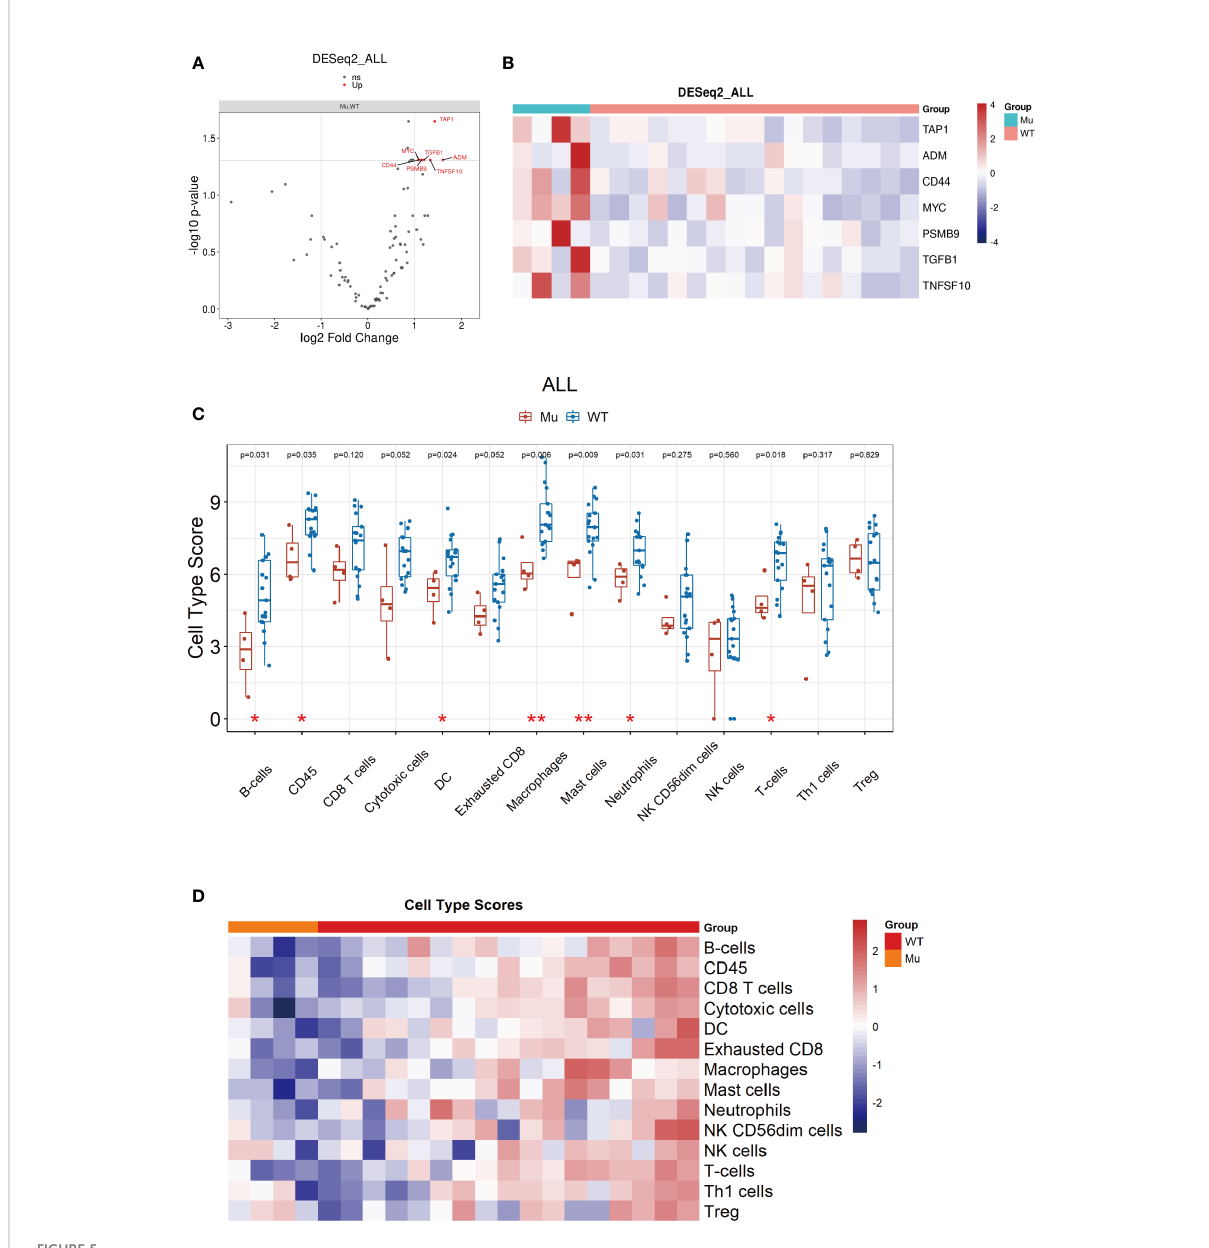
FIGURE 5 Identi fi cation of DEGs based on NOTCH1 mutation and immune cell pro fi le analyses. (A, B) DEGs were identi fi ed and shown by volcano plot and heatmap. (C, D) The immune cell composition assessment shown as heatmap and the scores of discrepant immune cell subsets in two